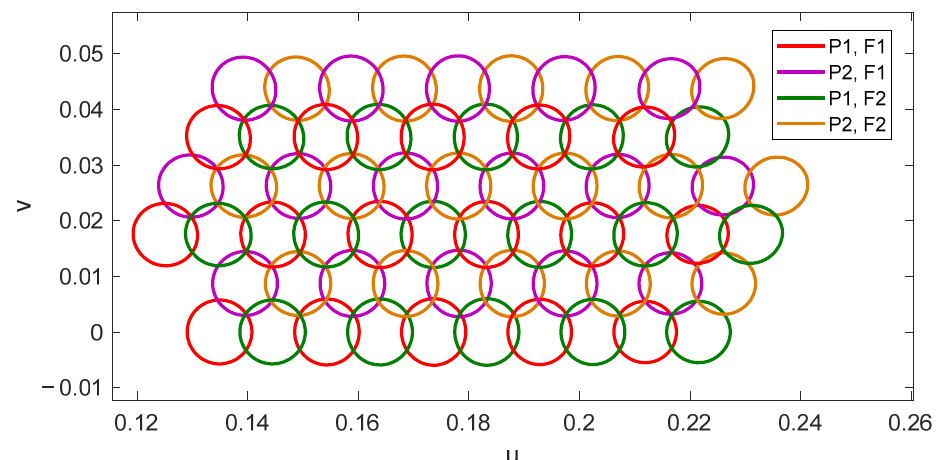
Figure 7. Simulated 46 dBi pattern contours of the 64 beams generated by 16 feeds in four different colors with a 1.8 m flat reflectarray.